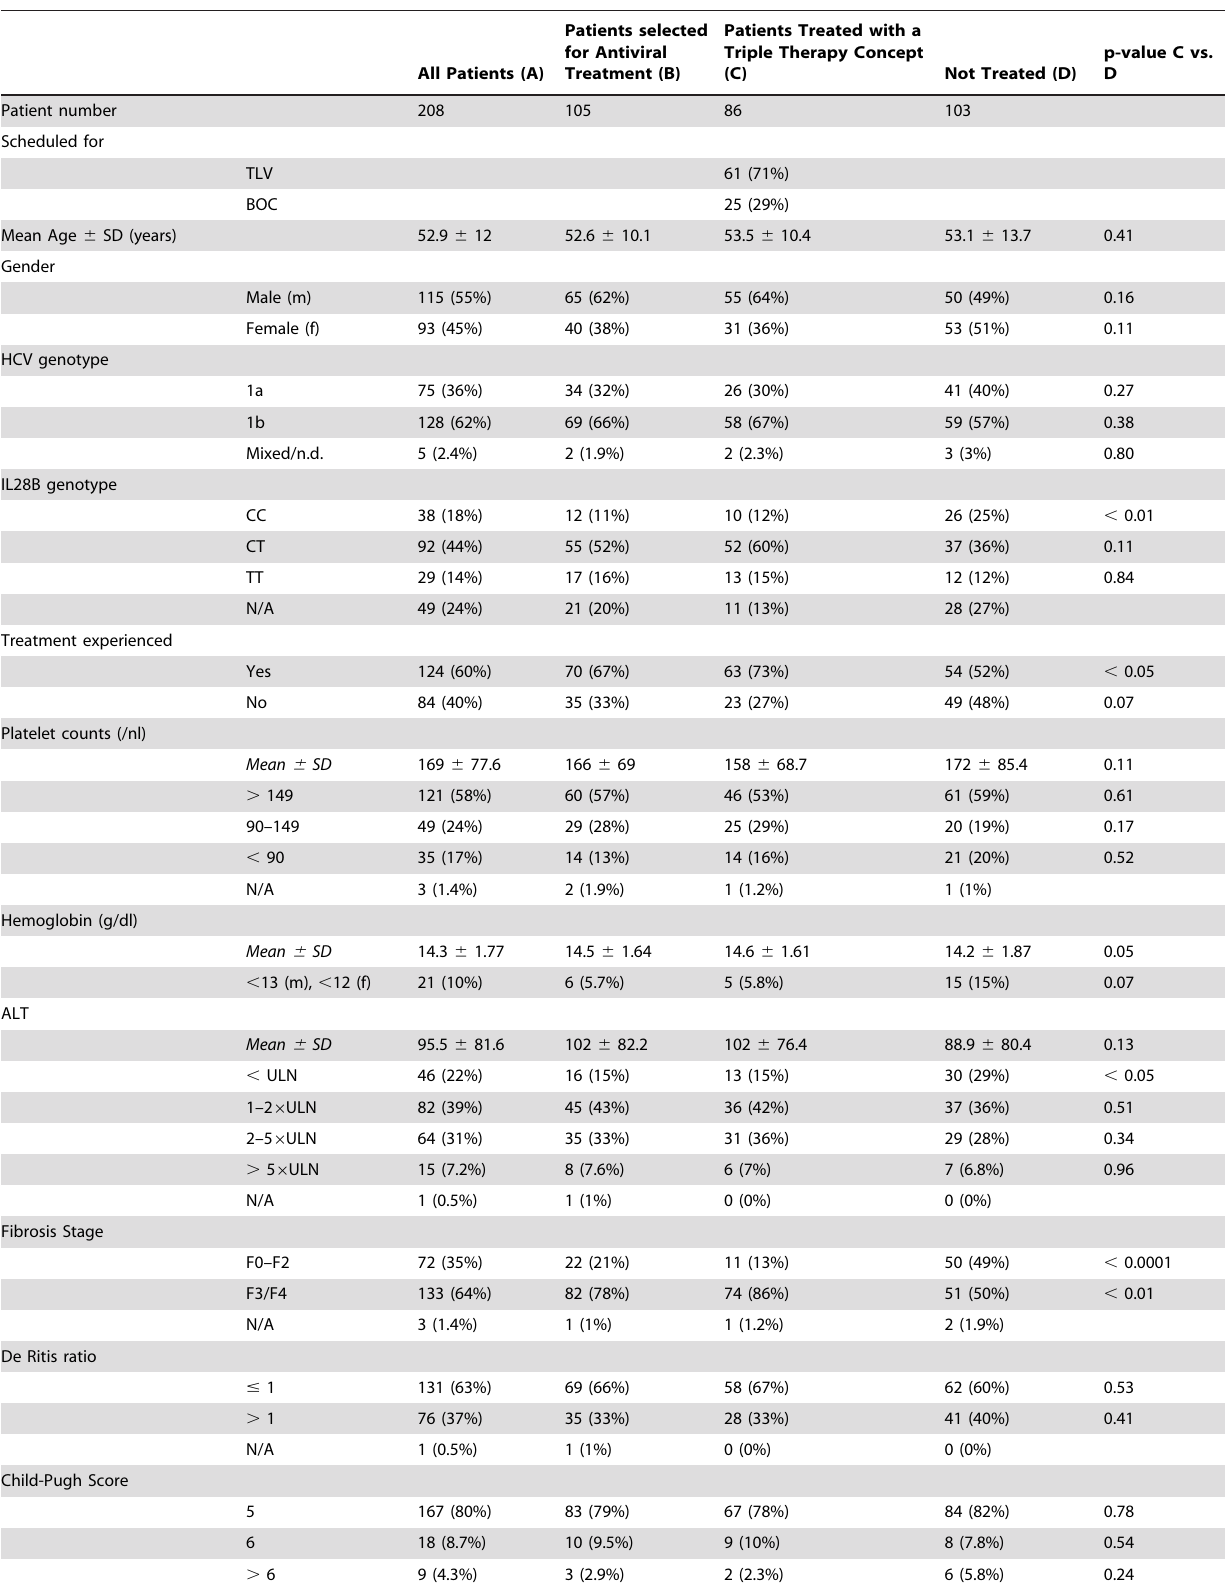
Table 1. Baseline characteristics of the study